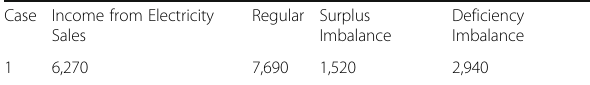
Table 4 (Abstract P12). Business Revenue Results for PV (YEN/year/kW)